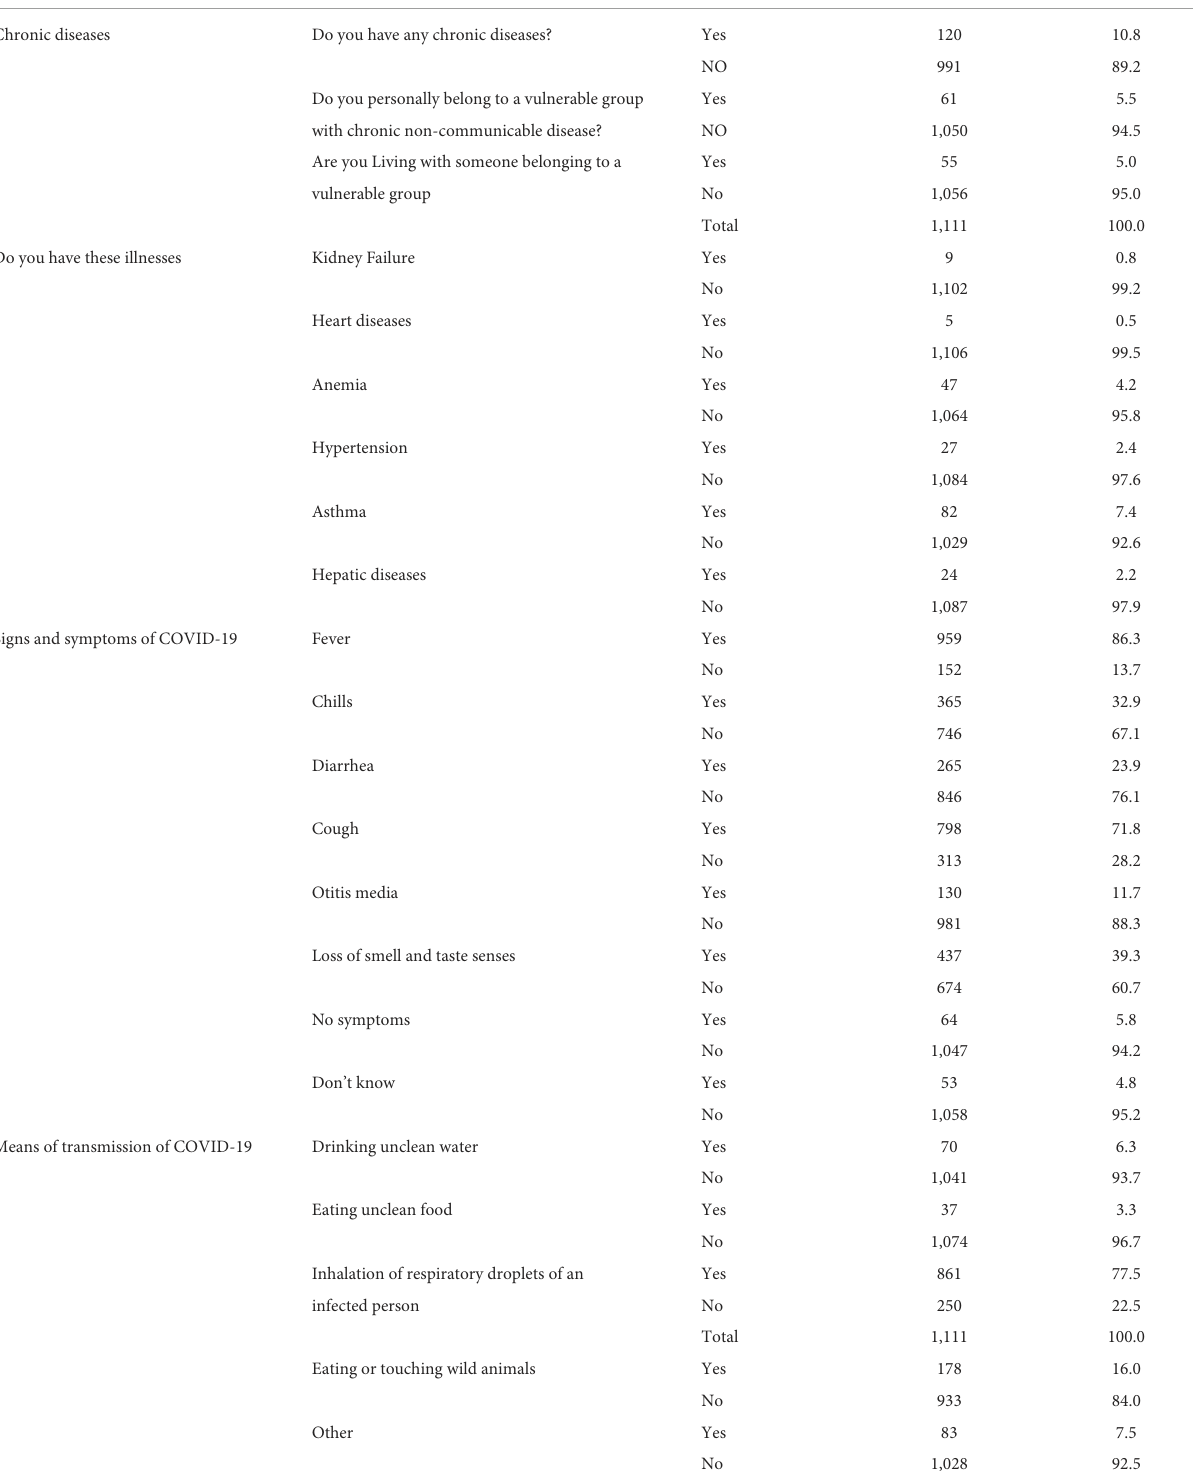
TABLE 2 Health status of study respondents and COVID-19-related